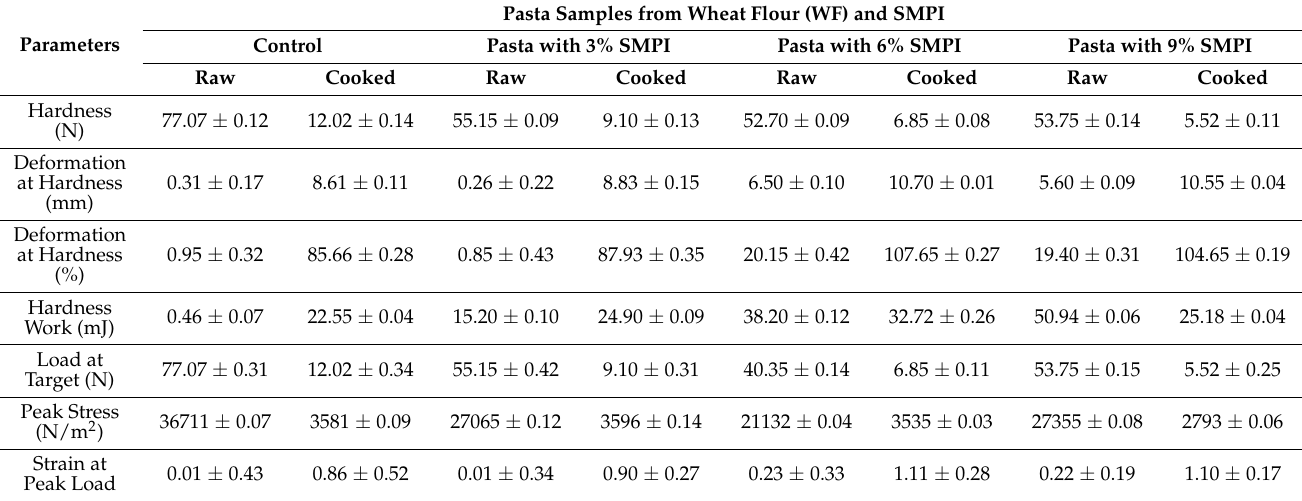
Table 7. Impact of mixing SMPI with wheat flour on texture profile analysis of